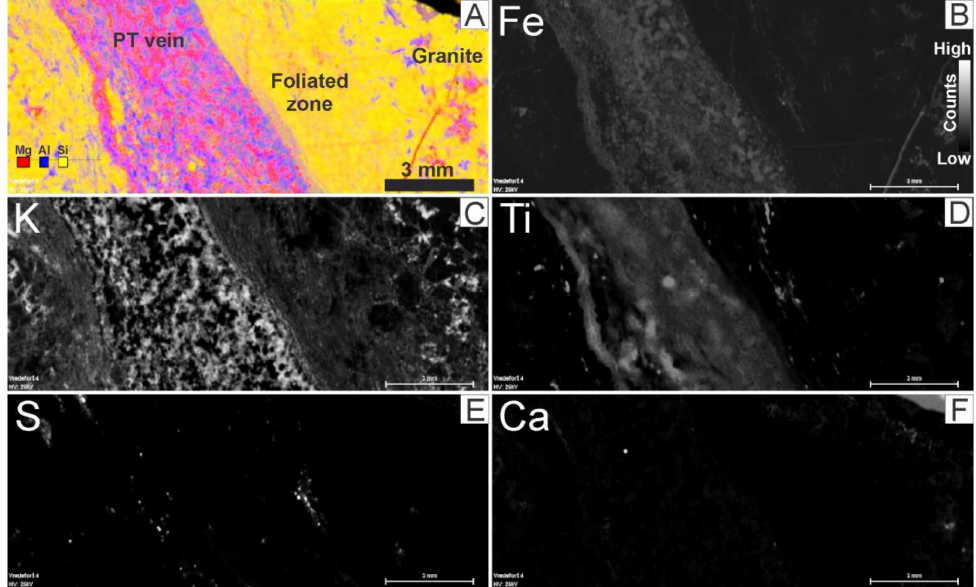
Figure 5. ED- µ XRF maps of a selected area in the thin section, shown by a large rectangle in Figure 4A. ( A ) Composite intensity map of Mg (red), Al (blue), and Si (yellow), showing that the PT vein is enriched in Mg and Al and depleted in Si with respect to the host clast. ( B ) Fe intensity map, showing that the PT vein is enriched in Fe. ( C ) K intensity map, showing that K distribution in the PT vein and the clast is patchy / inhomogeneous but is more homogeneous in the foliated zone. ( D ) Ti intensity map, showing that the PT vein is rich in Ti compared to the host clast. ( E ) S intensity map, showing S concentrated in patches within and around the PT vein. ( F ) Ca intensity map, showing that Ca is equally depleted within the PT vein and the clast. Scale as in ( A